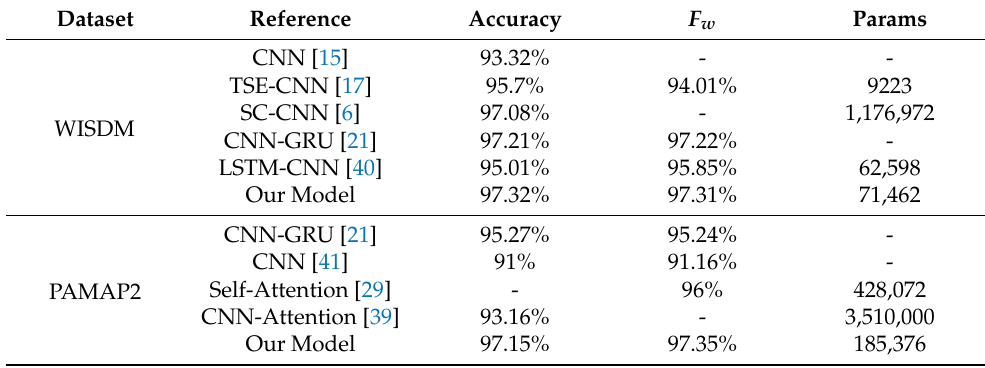
Table 6. Comparison with existing